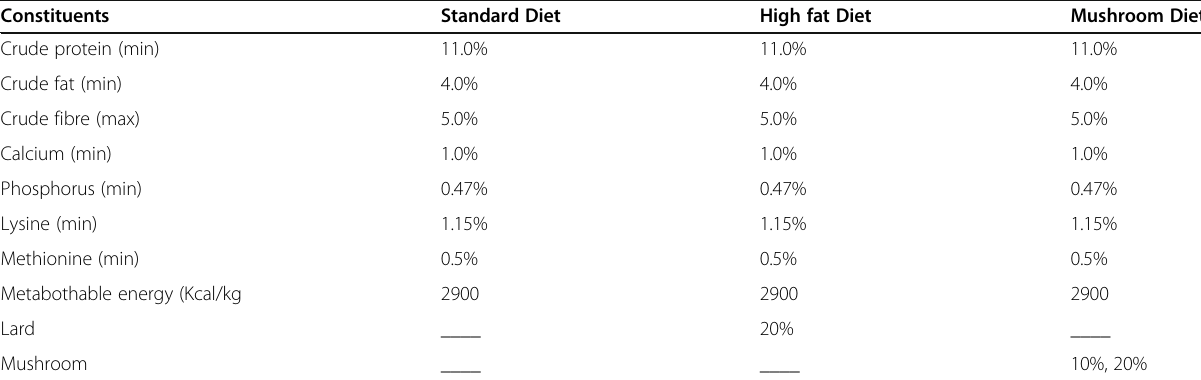
Table 1 Composition of the diets used in this study Constituents